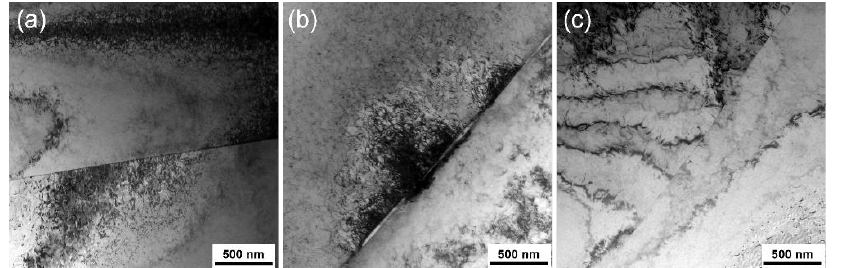
Figure 9. TEM bright-field image of grain boundary structure after tensile fracture at ( a ) room tem- ◦ C, and ( c ) 750 ◦ perature, ( b ) 700 °C, and ( c ) 750 °C. temperature, ( b ) 700